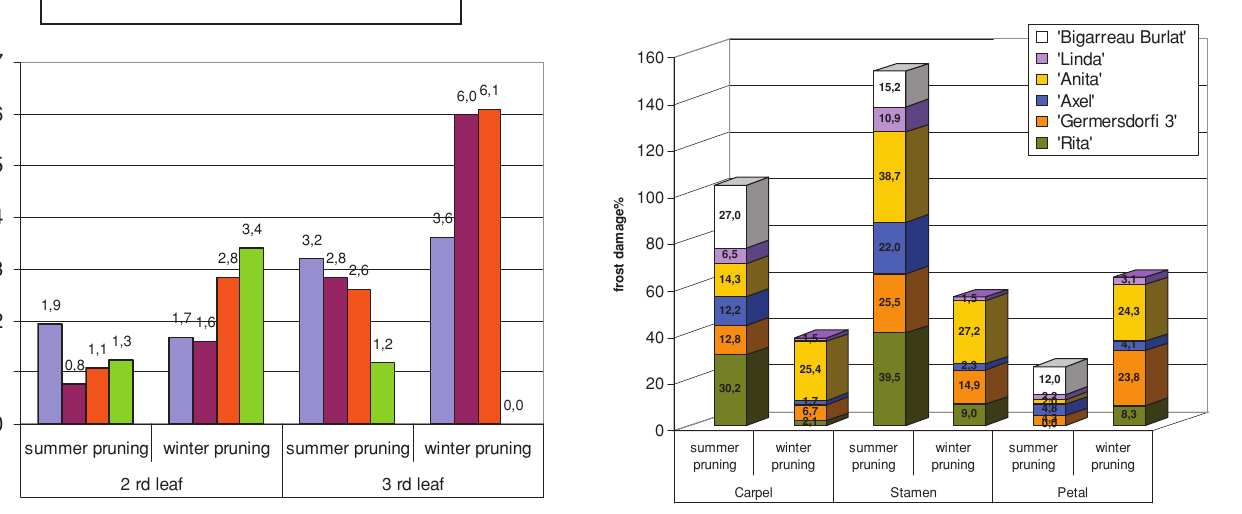
Figure 4. Frost damage of the organs within the flower buds and its distribution depending on pruning policies (Debrecen–Pallag